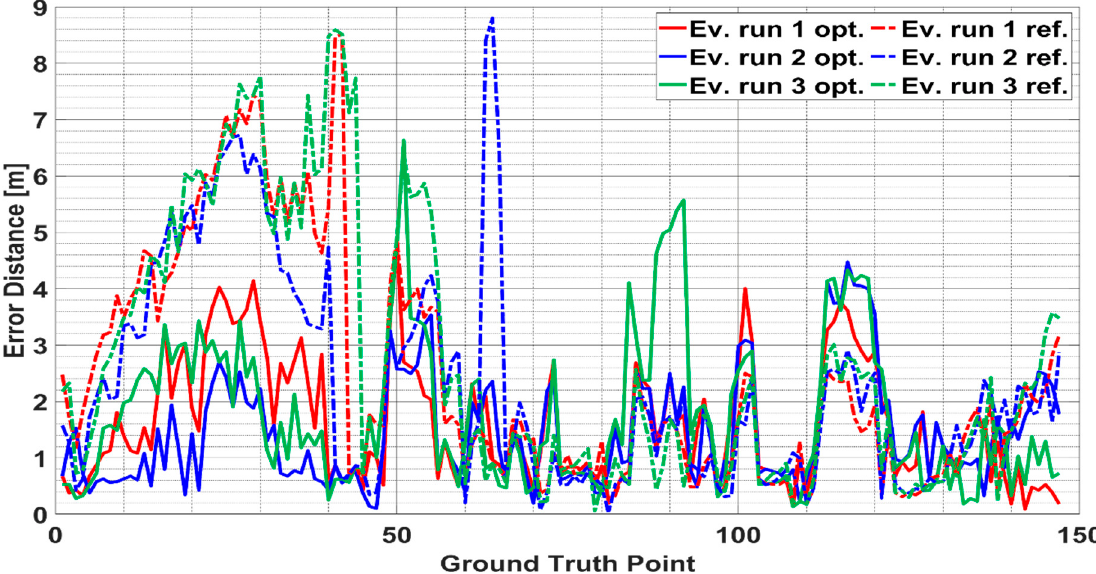
Figure 9. Position deviation of the evaluation runs for the Samsung Galaxy S7.